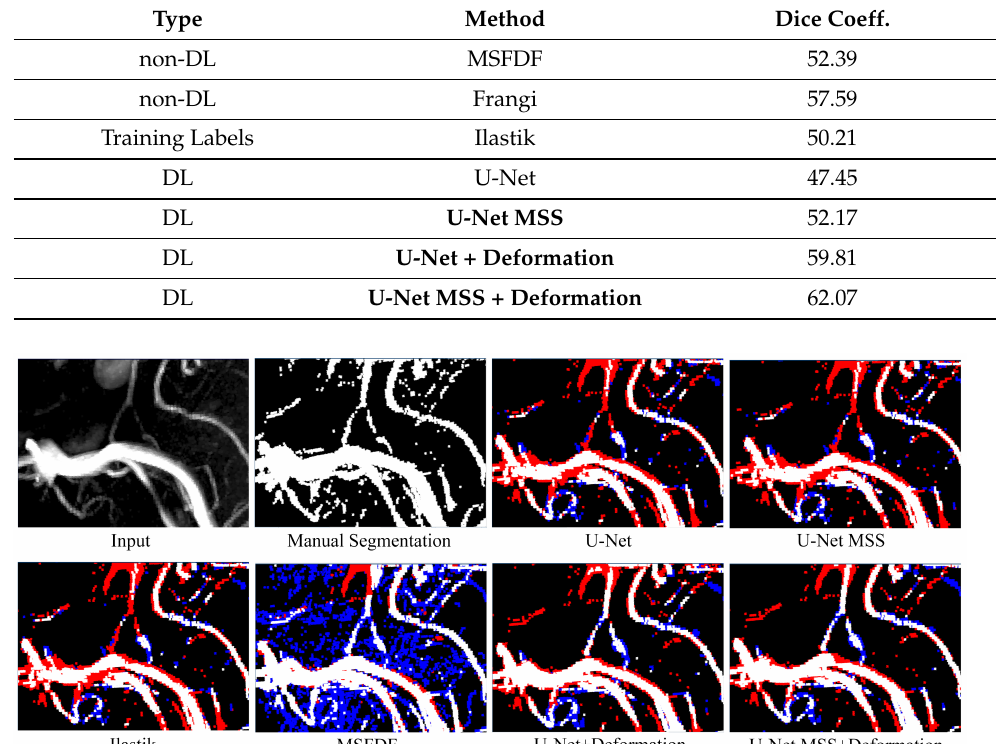
Figure 7. Qualitative evaluation of various methods with ROI-specific MIPs. The ROI was selected to feature large to small-scale vessels and enable qualitative comparison across segmentation methods. Red colour indicates the false negative while blue represents the false positive while being compared against manual